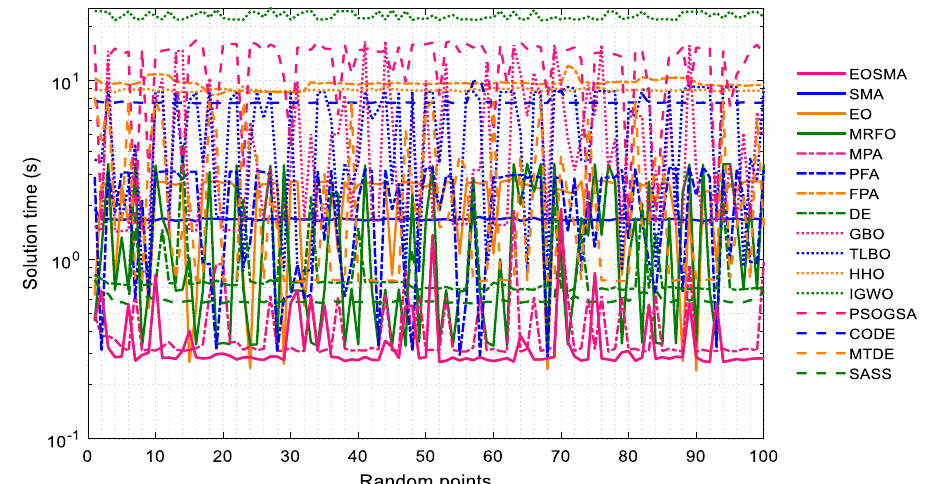
Figure 14. Solution time of comparison algorithms at randomly generated pose points.